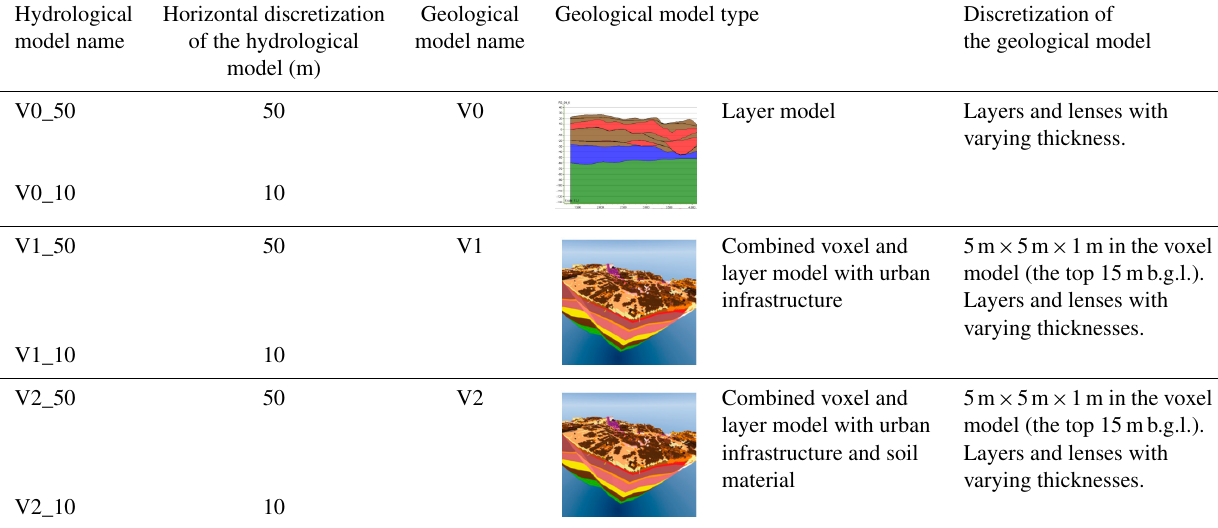
Table 1. Overview of models and their differences in discretization and geological model type. Note that b.g.l. is for below ground level.